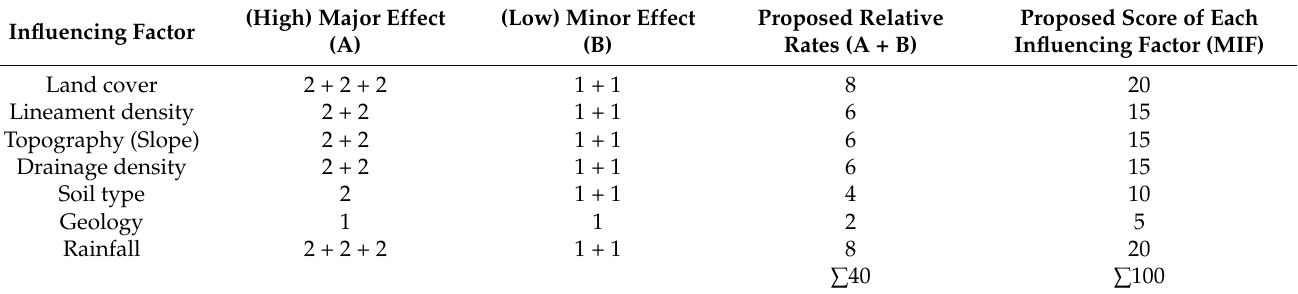
Figure 3. Interrelationship between the multi influencing factors concerning the groundwater potential zone. Table 1. Relative rates and score of each influencing factor (Major and Minor).